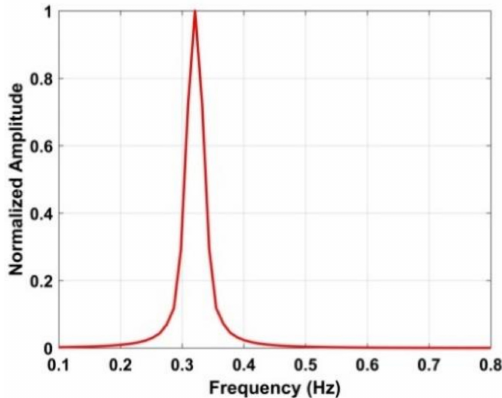
Figure 10. The normalized amplitude using four frequency accumulators with a human subject 6 m from the